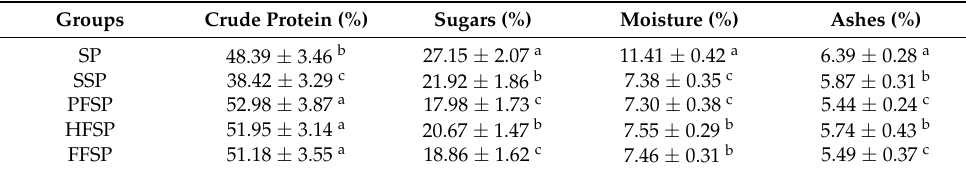
Table 1. Nutritional components of different soybean meal powders.